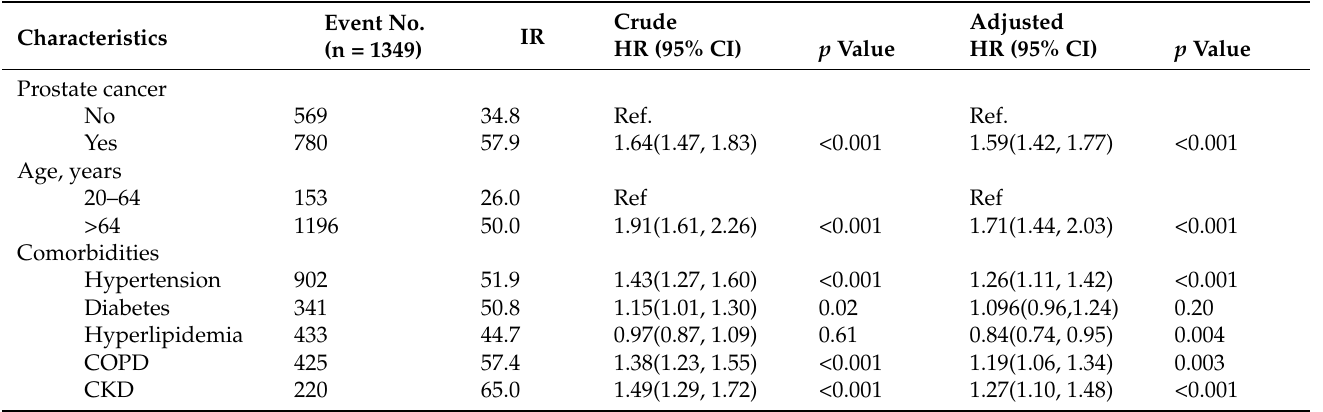
Table 2. Cox proportional hazard model analysis for the outcomes (including urinary tract infections, prostatitis, cystitis, and pyelonephritis) in the patients with and without prostate cancer.